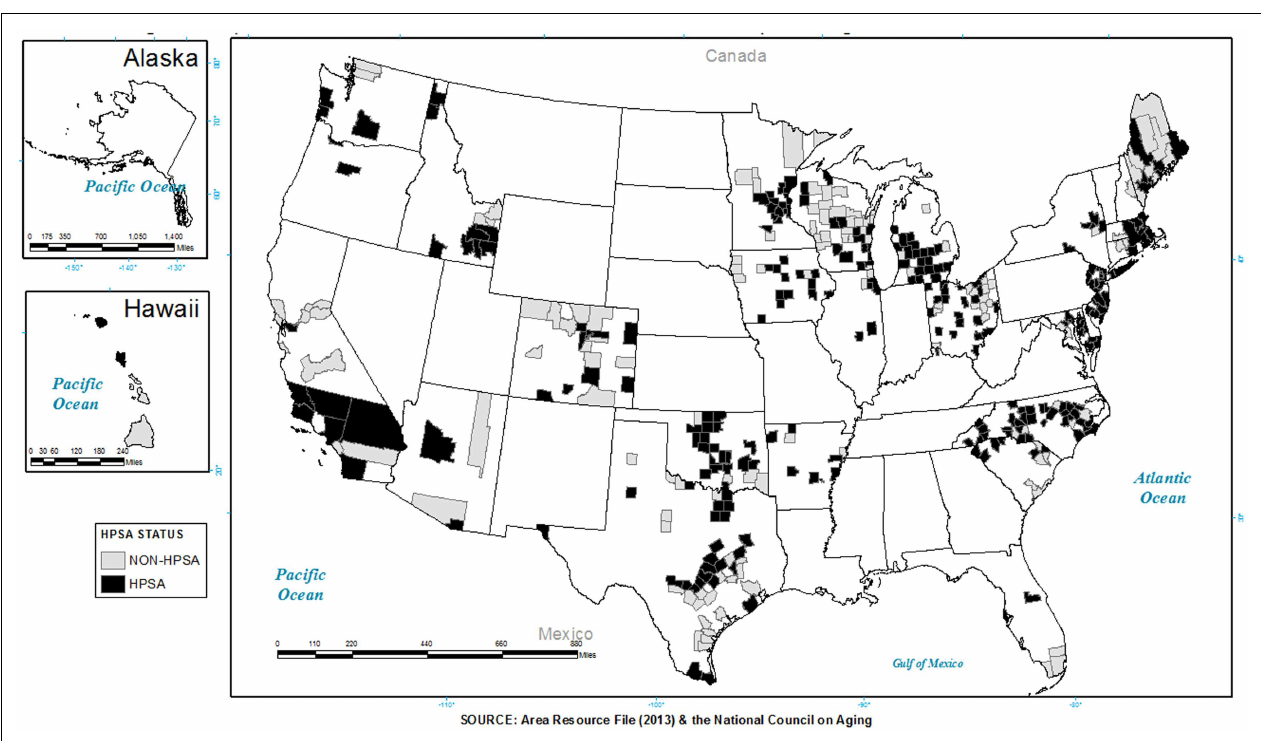
FIGURE 2 | Counties identified as a primary care health professional shortage area (HPSA) with a presence of evidence-based programs